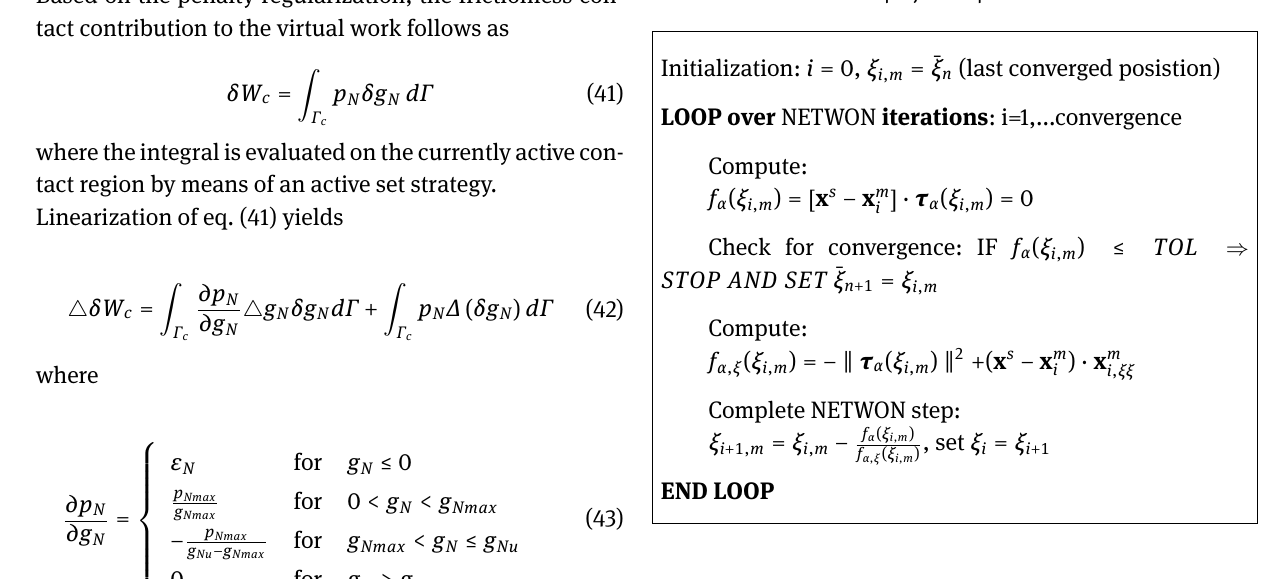
Table 1: Contact search for projection points.